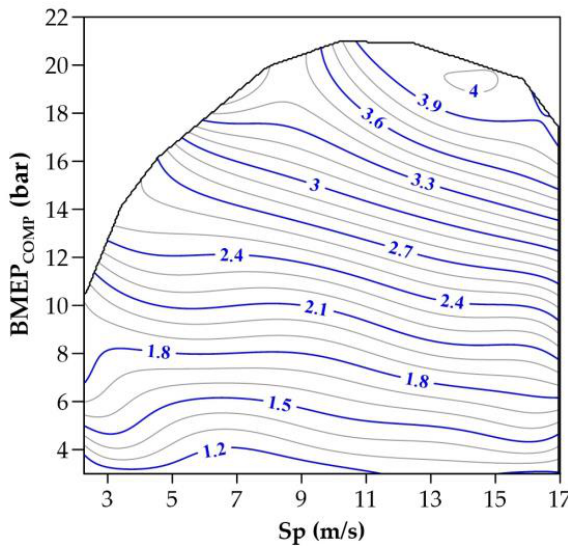
Figure 11. Optimal exhaust pressure levels of the compound engine as a function of load and mean piston speed.